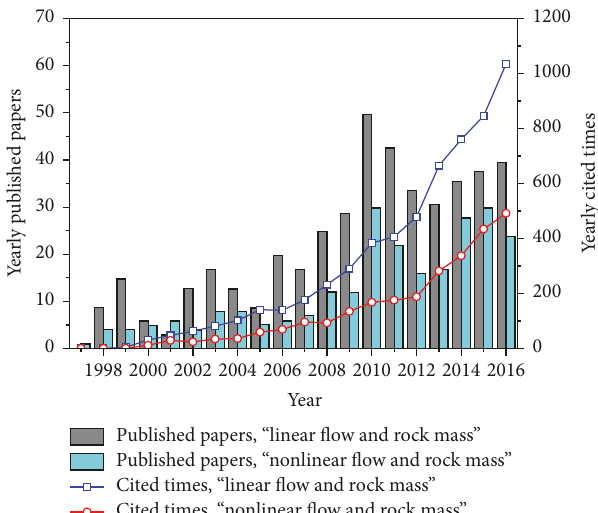
Figure 1: Yearly published papersand cited times with thekeywords “linear flow and rock mass” and “nonlinear flow and rock mass.” These data are collected from the Web of Science (cid:2) Core Collection (SCI-Expanded) over the past twenty years from 1997 to 2016.